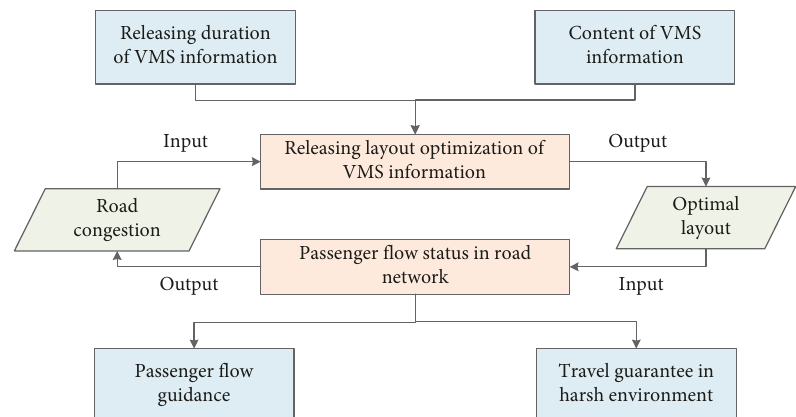
Figure 1: Feedback between information release and passenger flow state.